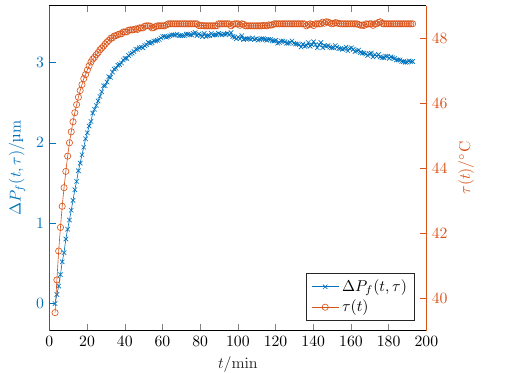
Figure 3. Shift of the focus position ∆ P f ( t ,τ ) with respect to the focus position observed in the first measurement (blue crosses). Camera temperature τ ( t ) over time t (orange